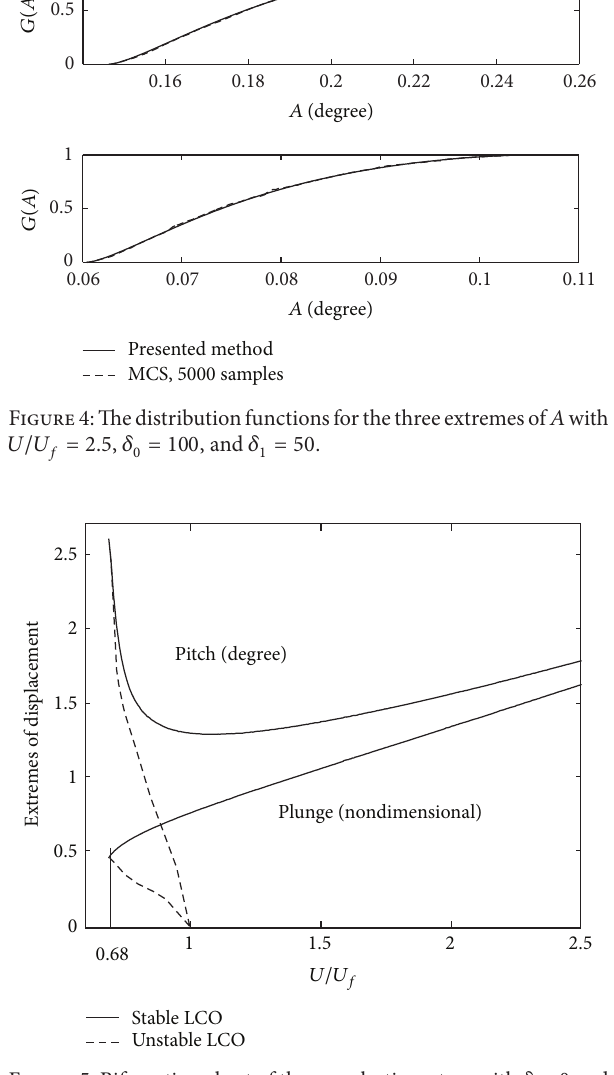
Figure 5: Bifurcation chart of the aeroelastic system with 𝛿 = 0 and 𝜂 = 80